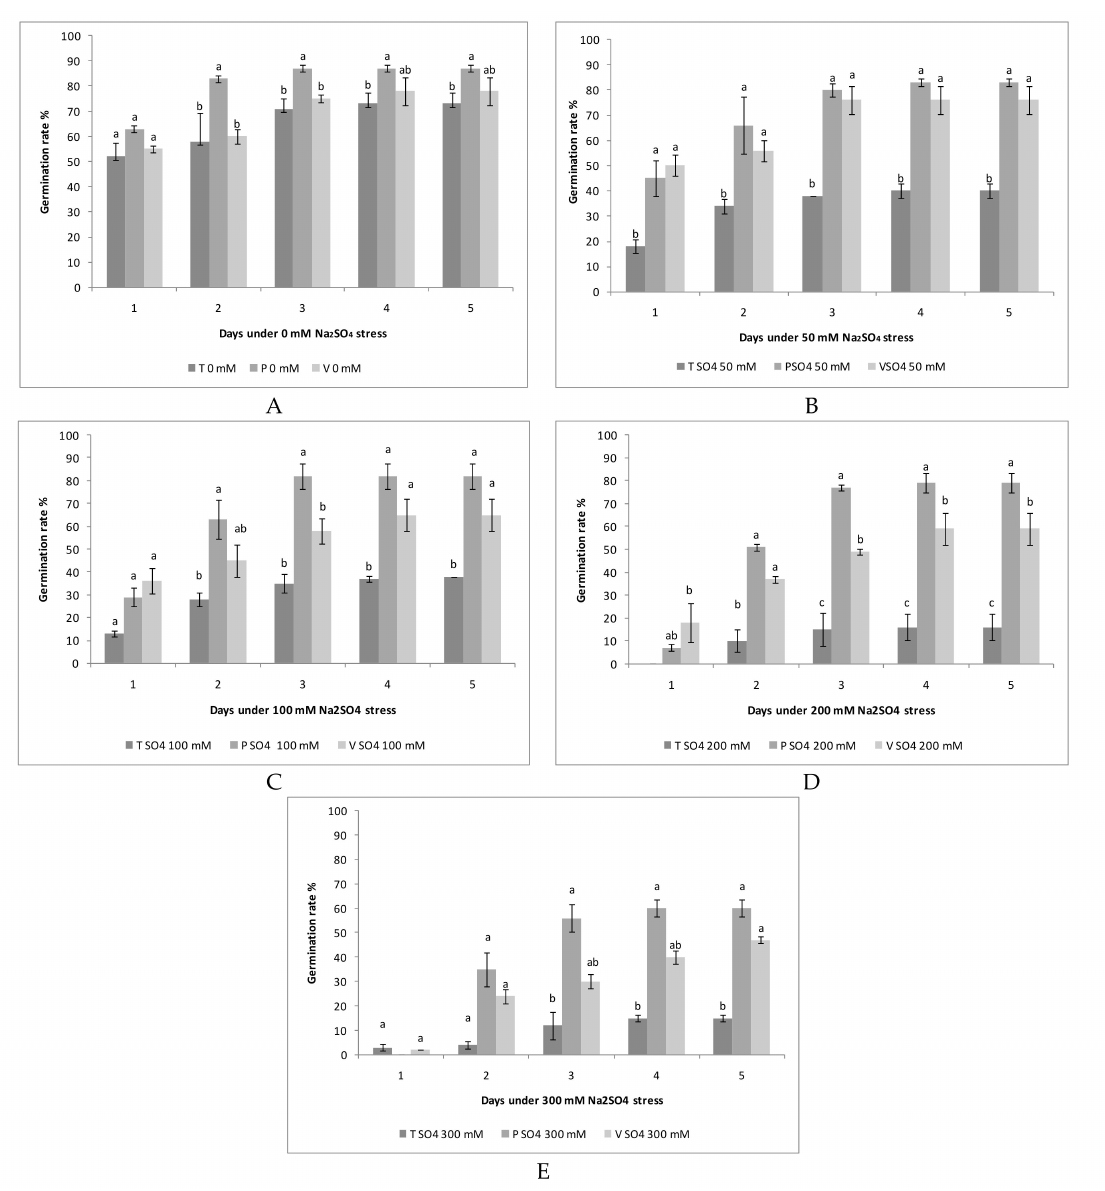
Figure 5. Comparisons between Titicaca (T), Puno (P) and Vikinga (V) cultivars under 0 mM Na 2 SO 4 ( A ), 50 mM Na 2 SO 4 ( B ), 100 mM Na 2 SO 4 ( C ), 200 mM Na 2 SO 4 ( D ), 300 mM Na 2 SO 4 ( E ) stresses. Di ff erent letter means significant di ff erences, according to Tukey test. Error bars indicate mean ±